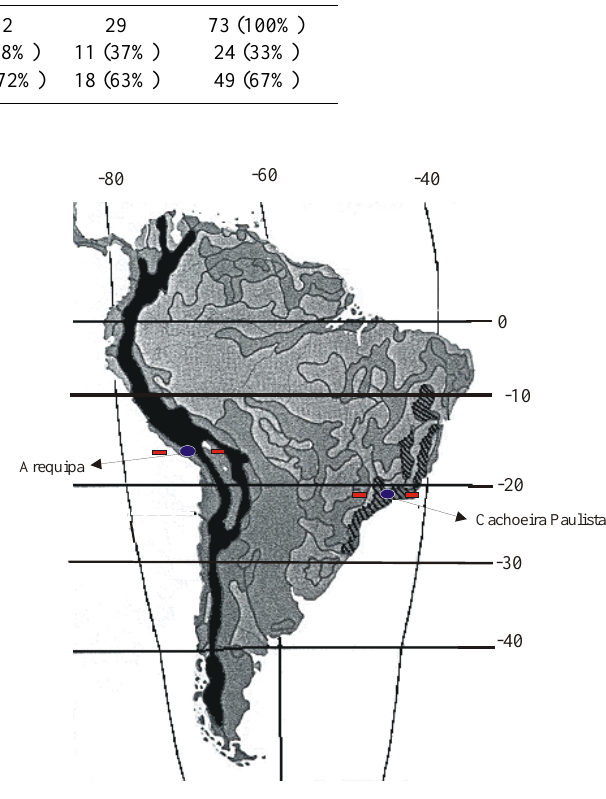
Fig. 1. Map of South America showing the location of the An- des Cordillera (left side - black) and of the Mantiqueira Moun- tains (right side - hatched) and the zonal sub-ionospheric points ( ∼ 270 km) for Cachoeira Paulista and